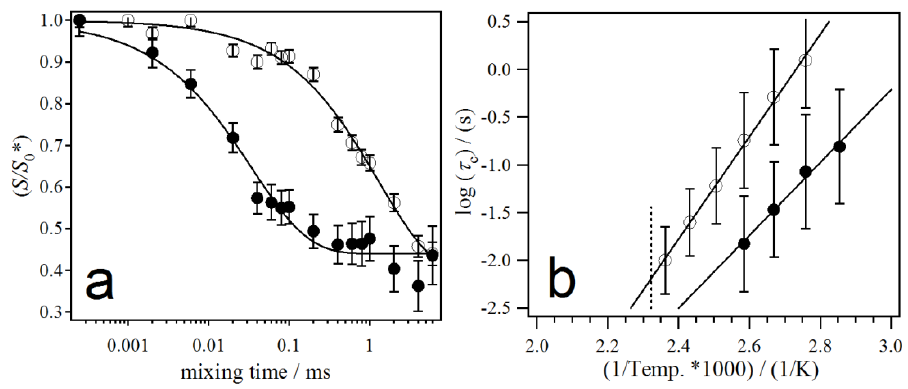
Figure 13. ( a ) CODEX mixing-time dependence of ( S / S 0 ) * signal intensities for i PP α 1 (●), and the i PP α 2 -rich samples ( ○ ) at 95 C. ( b ) Arrhenius plots of < τ c > of α 1 (●), and the α 2 -rich samples ( ○ ). (Reprinted with permission from J. Phys. Chem. B 2010 , 114 , 92 – 100. Copyright (2004) American Chemical Society).